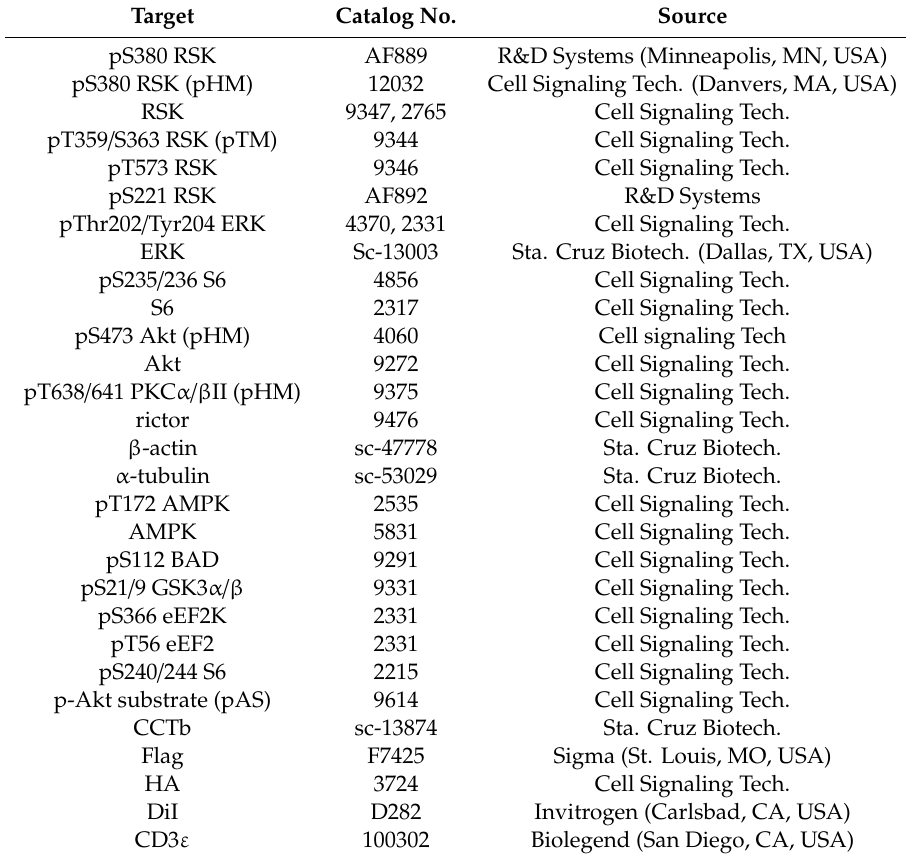
Table 1. List of Antibodies